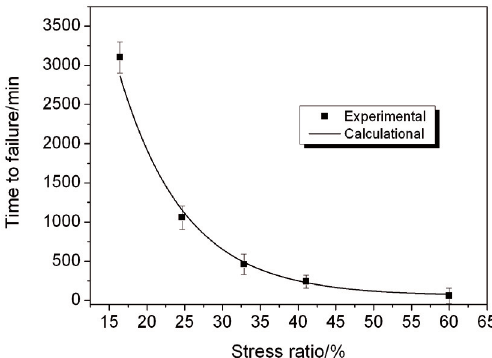
Fig. 6. Comparison of time to failure obtained by calcula- tional and experimental